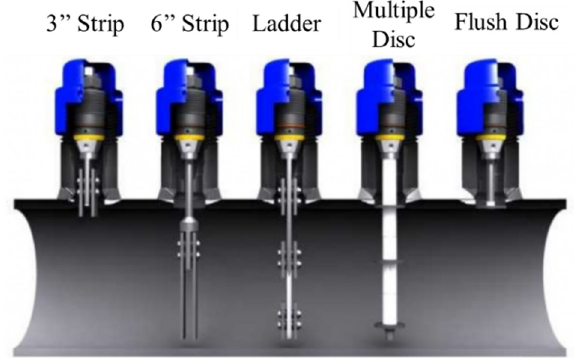
Figure 2. Corrosion coupons installed in the pipelines. The coupons are shown with a 90 o axial rotation from the normal angle [24] (Courtesy of Rohrback Cosasco Systems).